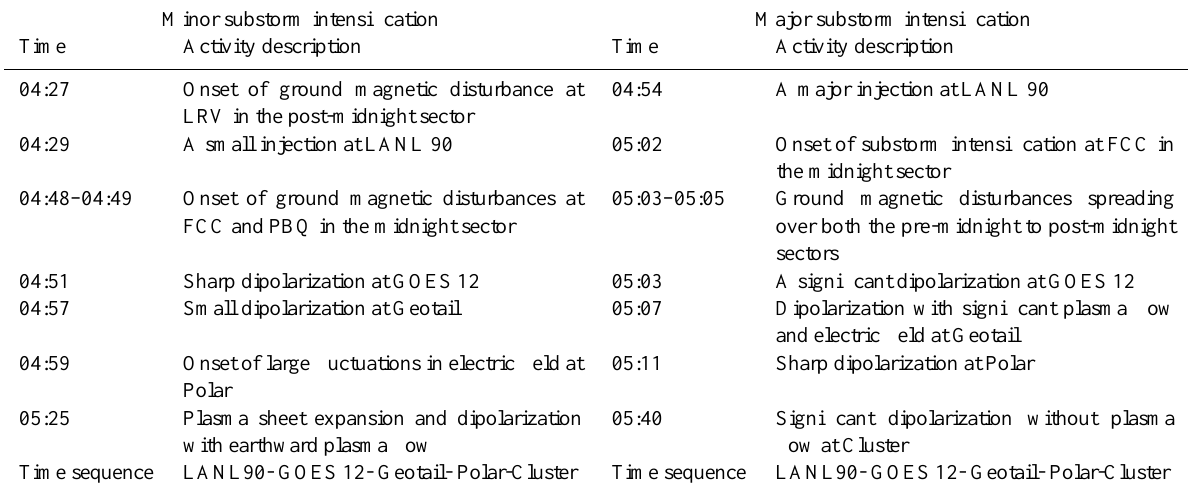
Table 1. Time line of substorm